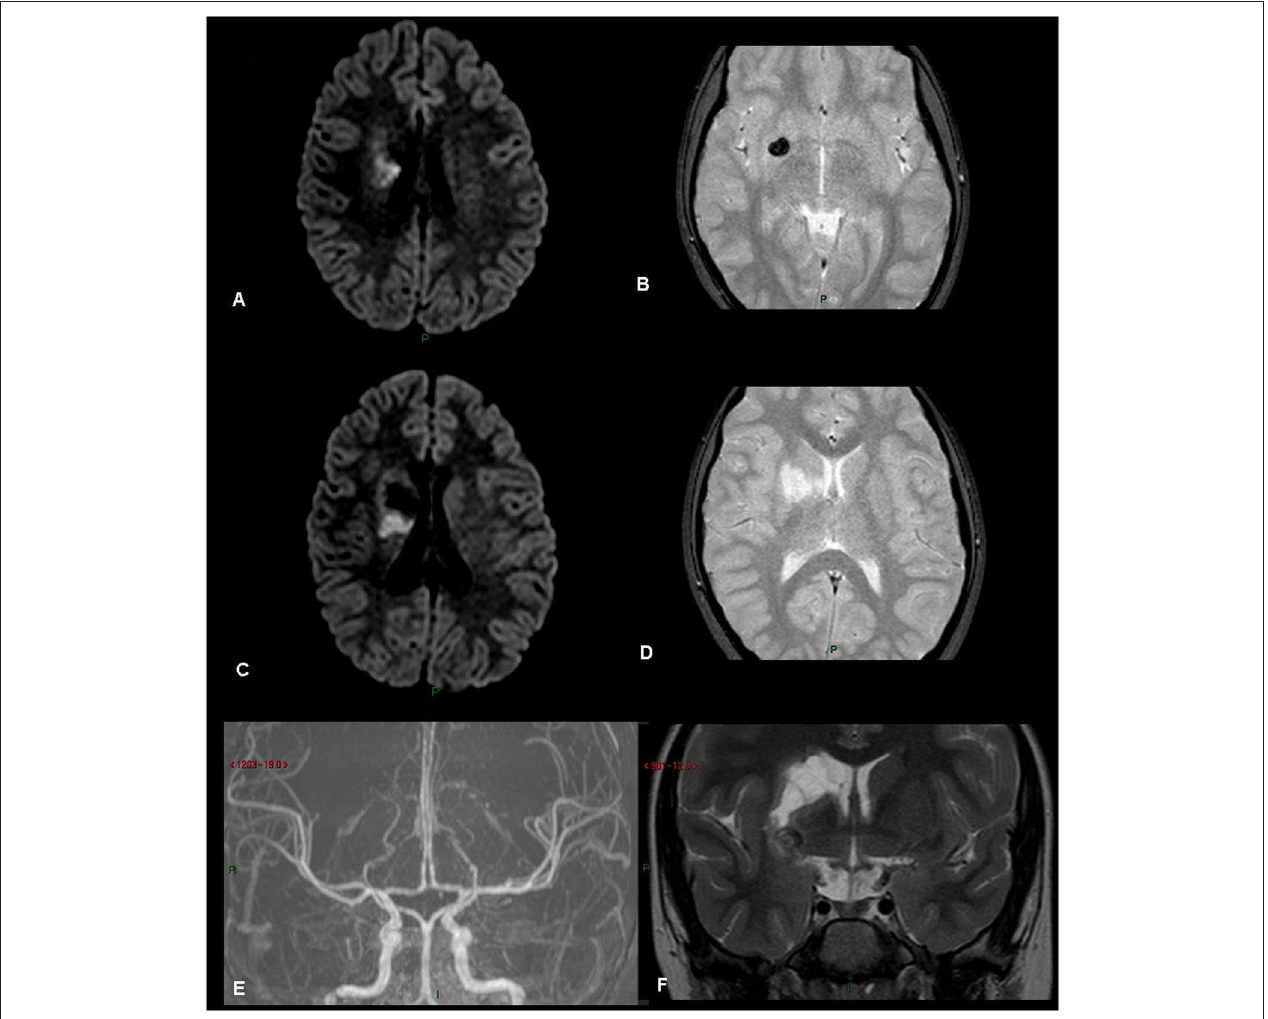
FIGURE 3 | Rt basal ganglia old infarct with hemorrhage. (patient 21, Table 1 ) (A) FLAIR. (B) Gradient Echo T2. (C) FLAIR. (D) Gradient Echo T2. (E) MRA TOS. (F) Coronal T2. Old right basal ganglia infarct with evidence of hemosiderin, old